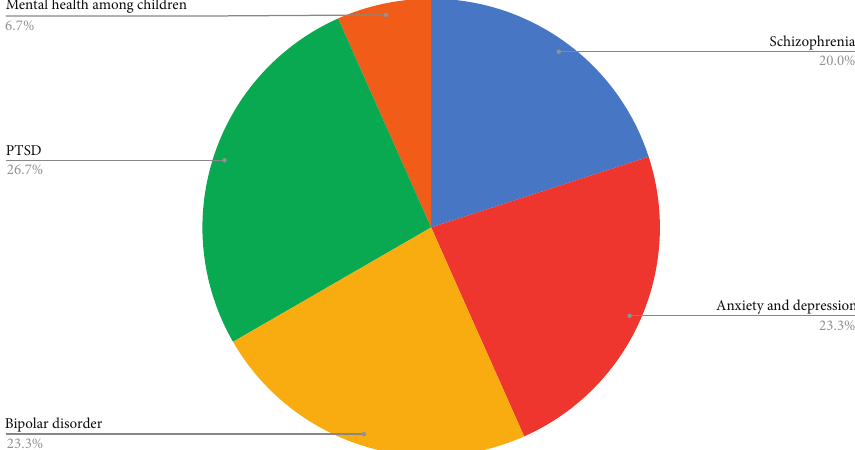
Figure 4: Percentage for the number of papers reviewed for each mental health